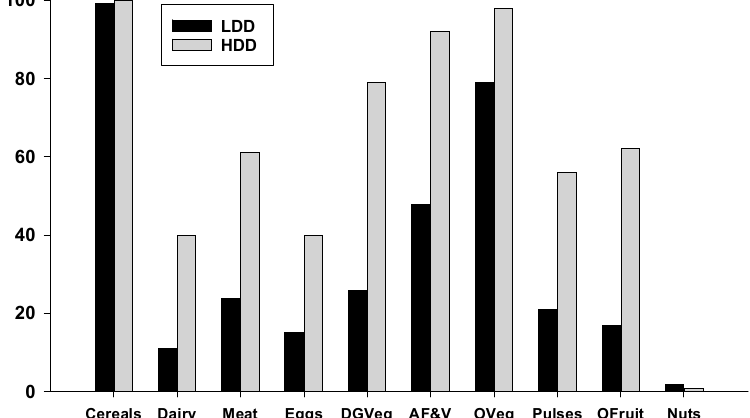
Figure 3. Percentage of LDD and HDD women home managers from small holder farms who consumed each of the 10 different food groups used to determine dietary diversity. All group differences are significant (Chi-square analyses, p < 0.0001) except for cereals, grains and nuts/seeds. Abbreviations: Cereals = grains, white roots and tubers and plantains; Meat = meat, fish, poultry; DGVeg—dark green vegetables; AF&V = vitamin A-rich fruits and vegetables; OVeg = other vegetables; OFruit = other fruits; Nuts = nuts and seeds. To further characterize agricultural food production diversity, we determined the percentage of